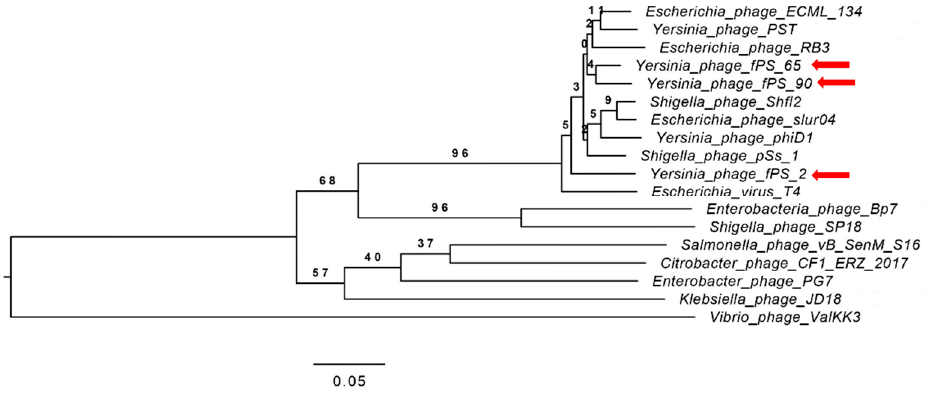
Figure 3. Phylogenetic tree generated by VICTOR using the complete genome sequences of fPS-phages and those of 15 other phages from the Myoviridae family. Phages fPS-2, fPS-65 and fPS-90 are indicated with red arrows.